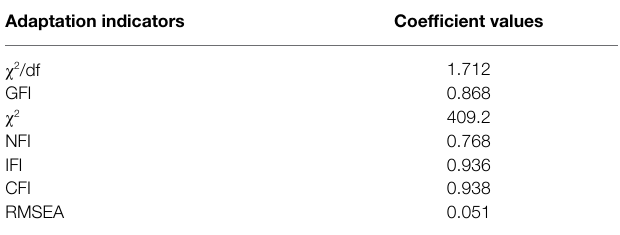
TABLE 6 | Equation model fitting